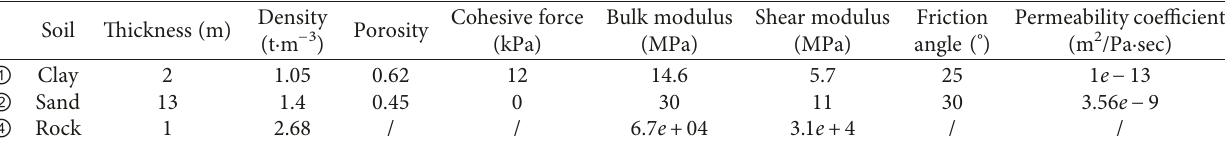
Table 1: The distribution of soil layers and physical and mechanics parameters of the numerical simulation model corresponding to two soil layers.